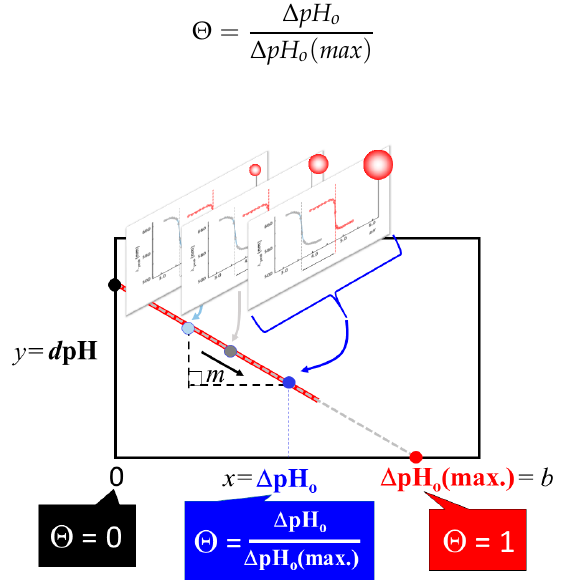
Figure 13. For each amyloidogenic peptide, d pH obtained by Equation (1) by analyzing each sigmoidal plot (See Figure 12b) was plotted as a function of ∆ pH o . The coverage ratio, Θ , for each gold colloidal size was obtained by scaling the data point, based on the x-axis intercept Θ = 1 (See Equation (2)) Each data point corresponds to di ff erent nano-gold colloidal size and was obtained by analyzing sigmoidal plot shown in Figure 12b) for bare gold and amyloidogenic peptide coated gold.